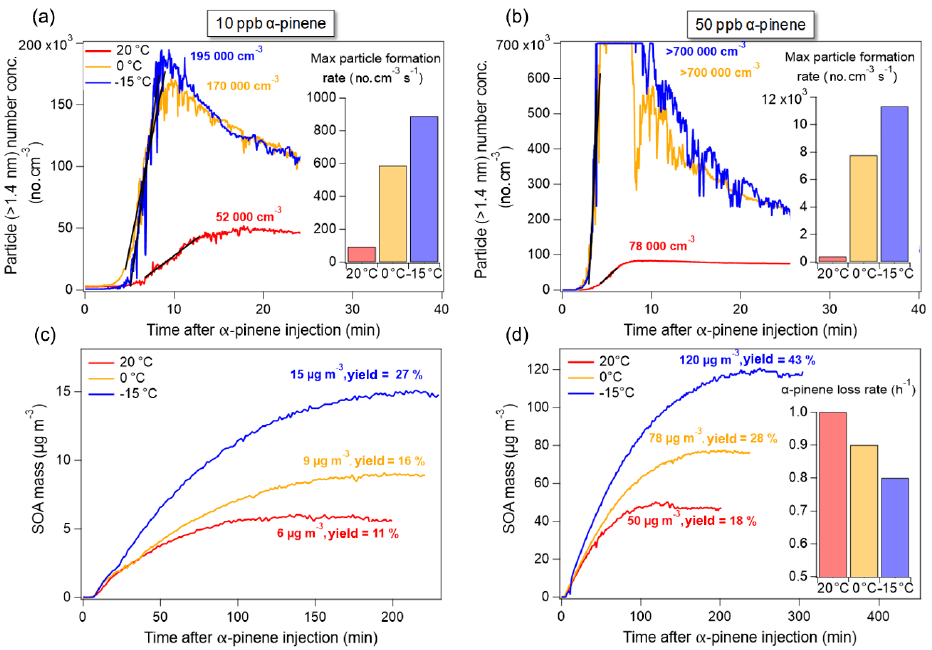
Figure 2. Effect of reaction temperature and initial VOC concentration on SOA formation with respect to (a, b) particle number concentration and (c, d) wall-loss-corrected SOA mass concentration at α -pinene concentrations of (a, c) 10ppb and (b, d) 50ppb. Insets show particle- formation rates (no.cm − 3 s − 1 ) as estimated from linear fits to the (a, b) experimental data. The inset in (d) shows the loss rate of α -pinene (h − 1 ) at different temperatures as derived from an exponential fit to the measured concentration of α